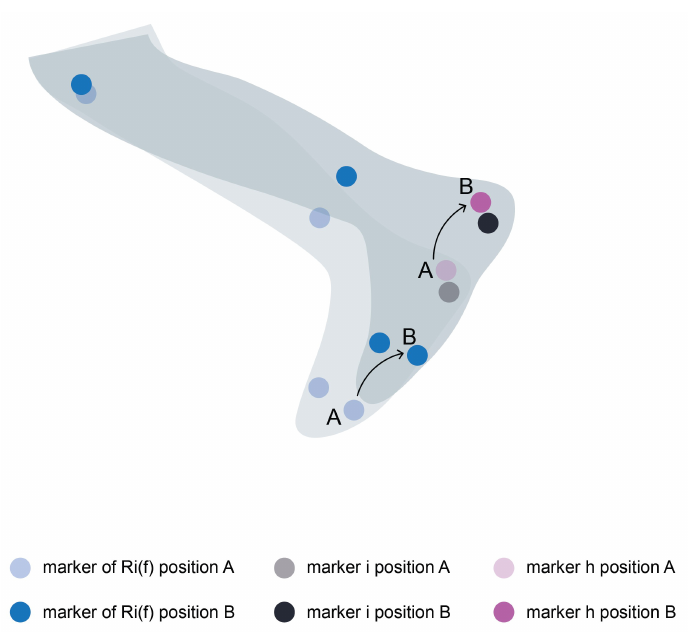
Figure 3. Example of a pair of markers for which their relative movement is mostly constant over the course of the